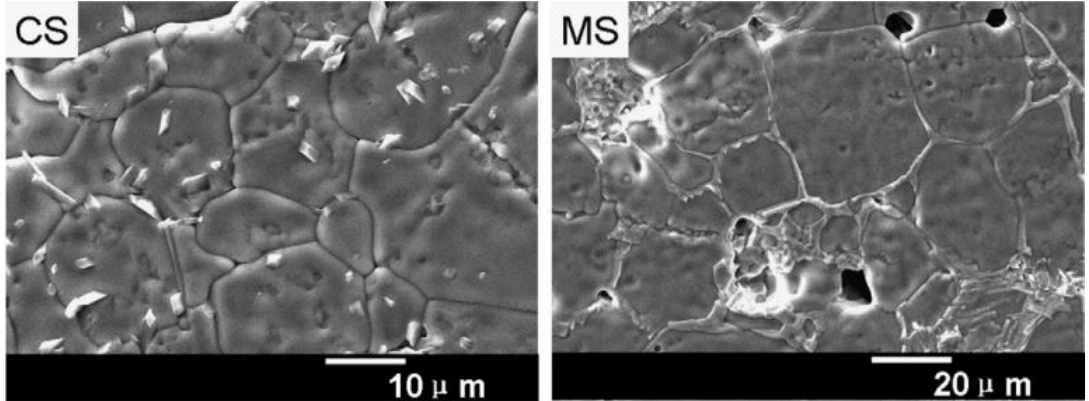
Figure 11. SEM images of sintered pellets from MS and CS powder [23].